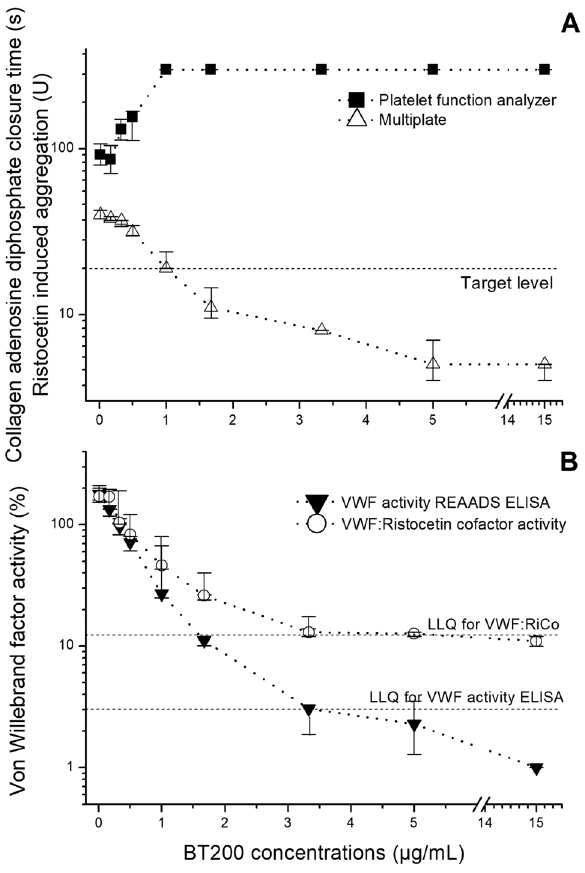
Figure 1. Concentration effect curves of the von Willebrand factor (VWF) inhibiting aptamer BT200 on platelet plug formation under high shear stress, ristocetin-induced whole blood aggregation ( A ), VWF activity and ristocetin cofactor activity (RCo; B ) in patients with large artery atherosclerosis stroke or transient ischemic attacks. BT200 was spiked ex vivo into plasma or whole blood. Collagen adenosine diphosphate closure time (CADP-CT) and aggregation were measured by the platelet function analyzer PFA-100 and Multiplate. Data are presented as median values and the interquartile